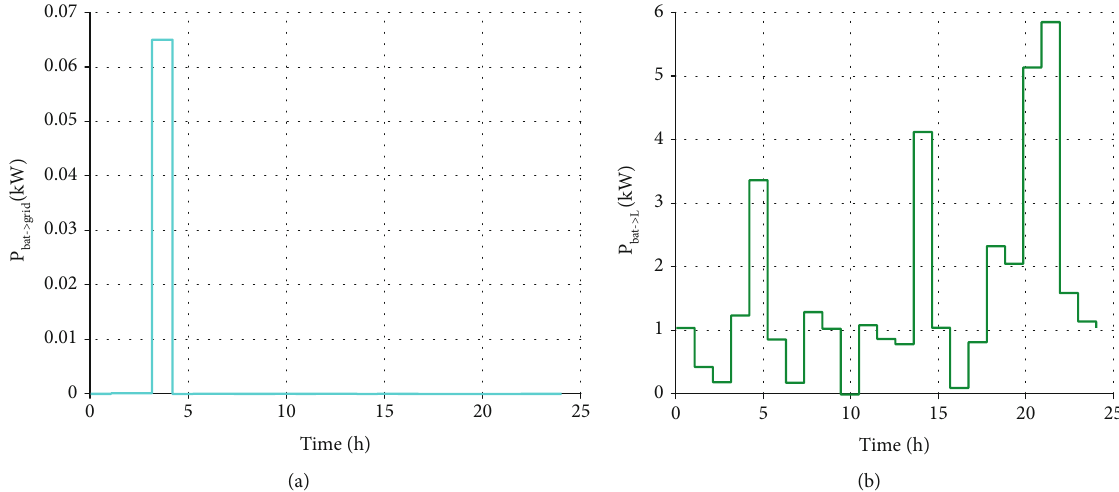
Figure 19: (a, b) Discharged power from the battery to the grid and load by the hybrid algorithm, respectively.